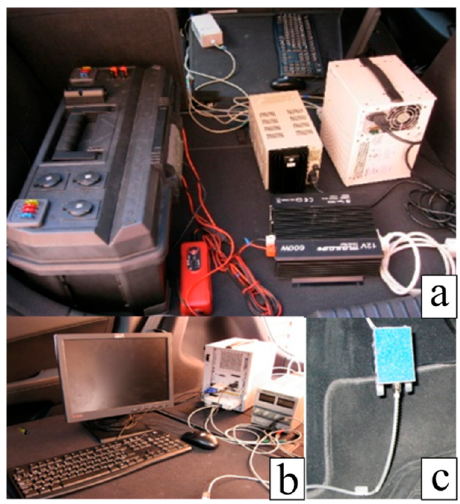
Figure 1. Power supply and devices used to convert the DC supply from the external battery to AC ( a ) to feed the acquisition system ( b ) and the force pedal ( c